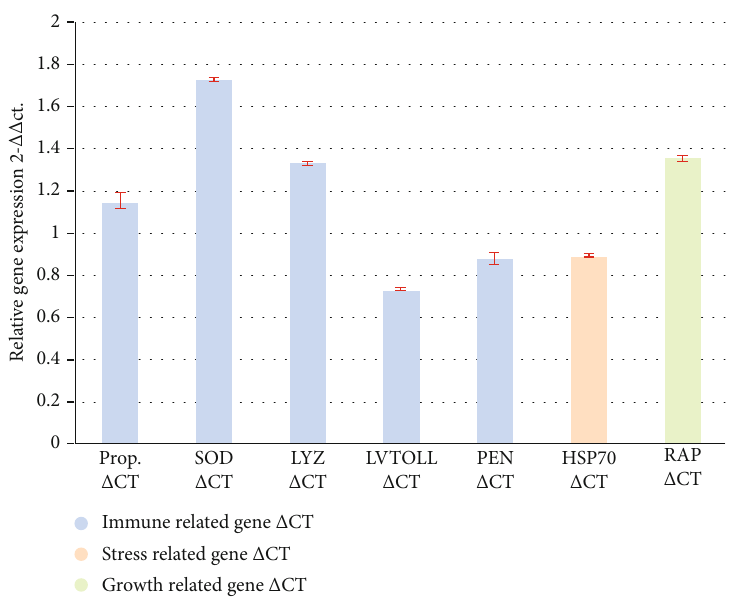
Figure 3: Relative expression levels ( mean ± SD ) of P. vannamei hemolymph immune, stress, and growth-related genes after a 135-days rearing period under a density of 100 org./m 2 as compared to the control group (300org./m 2